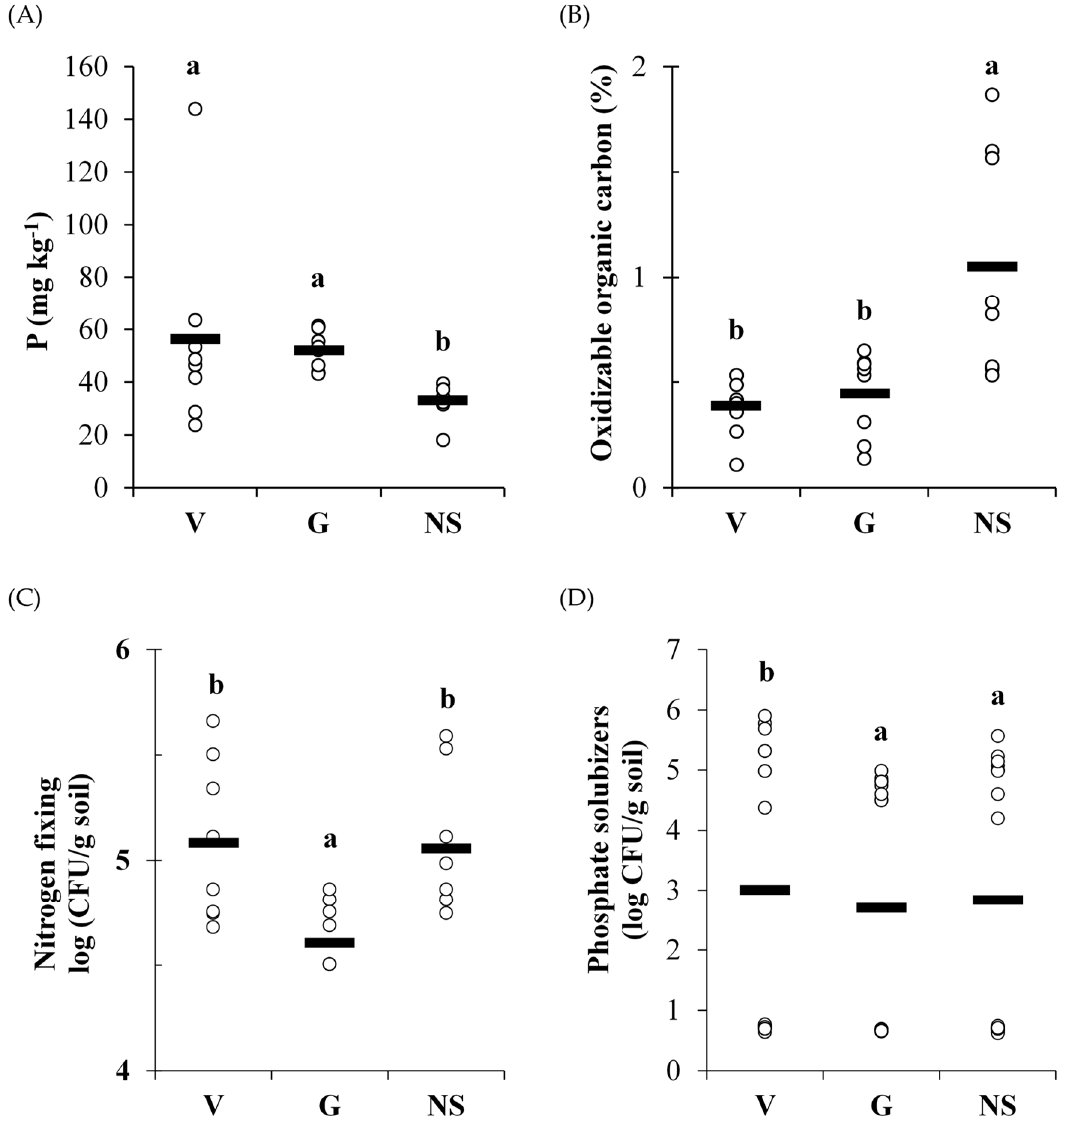
Figure 2. Effects of the olive pruning shape, vase (V), globe (G), and natural shape (NS), in olive trees rhizosphere soil on ( A ) P contents. Nemenyi test following Kruskal–Wallis H test was used to compare P content in rhizospheric soil between pruning treatments. ( B ) Oxidizable organic carbon. After beta regression, pairwise comparisons using Tukey’s adjustment were used for comparing pruning treatments. ( C ) Nitrogen-fixing microorganisms count and ( D ) Phosphate solubilizers microorganism count were fitted to a negative binomial model and the differences between pruning treatments were tested with pairwise comparisons using Tukey’s adjustment. Different letters denote significant ( p < 0.05) differences between the means. Figures are plotted according to Weissgerber et al. (2015)